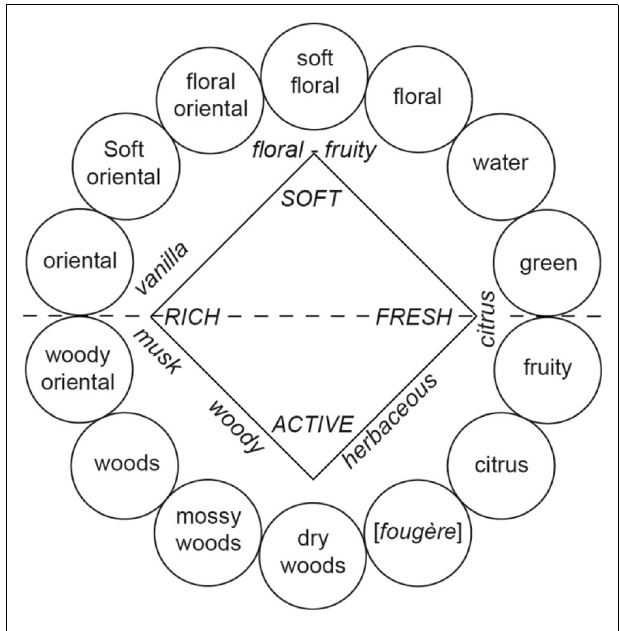
FIGURE 2 | Fragrance wheel. Fourteen perfume categories (within circles) are depicted. For the purposes of comparison, the odor effects diagram (inner square, letters in italics) proposed by Calkin and Jellinek (1994) is also illustrated (with permission from Zarzo and Stanton,